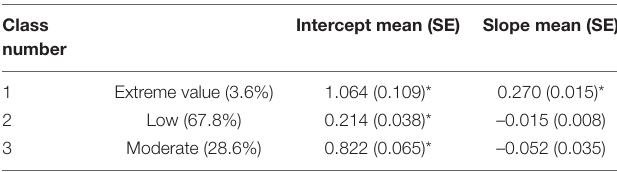
TABLE 3 | Growth factor parameter estimates for three-class conditional model.